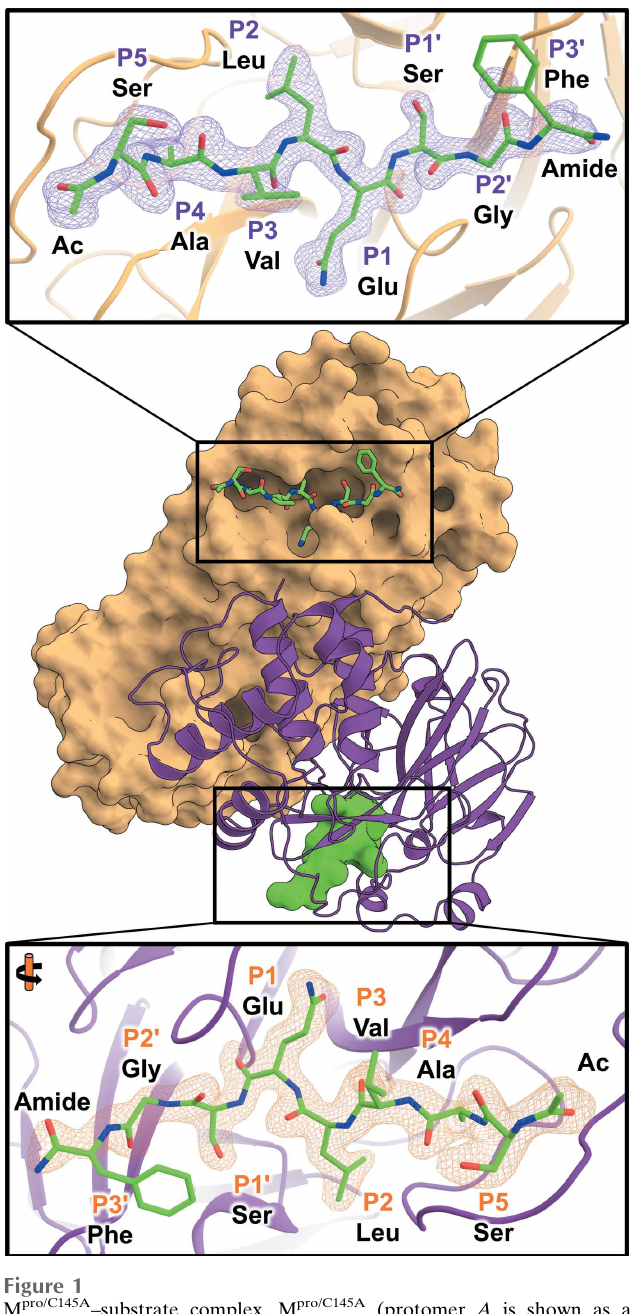
Figure 1 M pro/C145A –substrate complex. M pro/C145A (protomer A is shown as a purple cartoon and protomer B as an orange surface) was co-crystallized with an octapeptide (green sticks and surface) corresponding to the nsp4/ nsp5 autocleavage site. The top inset shows the peptide in protomer B in conventional orientation, while the bottom inset shows protomer A rotated by 180 (cid:6) . F o (cid:3) F c omit difference electron-density maps for each peptide are contoured at 3 (cid:4)